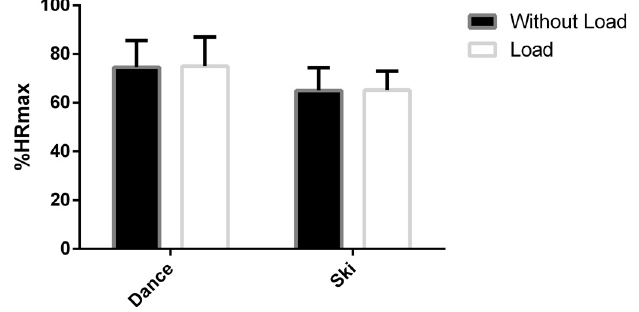
Figure 1. Percentage of maximal heart rate (HRmax) during Just Dance and Ski exergame with and without additional load.